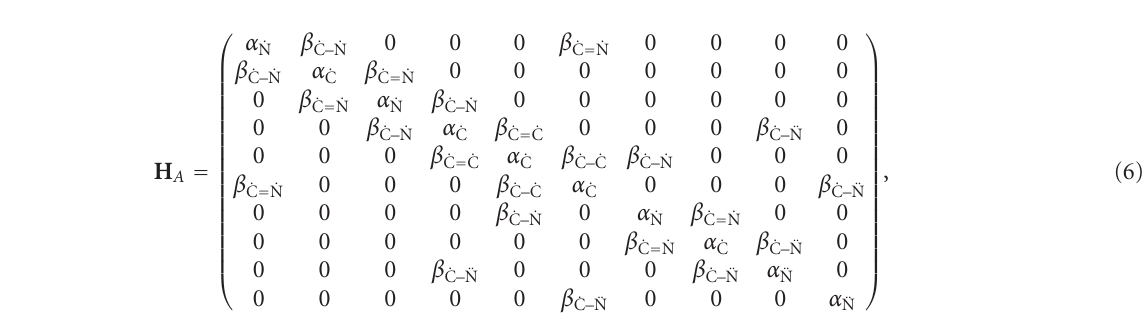
Figure 2: (a) The spectrum of the π -orbitals of A, G, C, and T. (b) The spectrum of the π -orbitals of a sugar-phosphate group. PO 4 stands for the phosphate group where the electron hopping between the oxygen sites is taken into account, while PO (cid:7) where the electron hopping between the oxygen sites is forbidden. SP stands for the sugar-phosphate group where the electron hopping between the oxygen sites is taken into account. The energies are measured in units of | β | . Here dots ( • ) mean π -electrons and the level with four dots means the double degeneracy of the